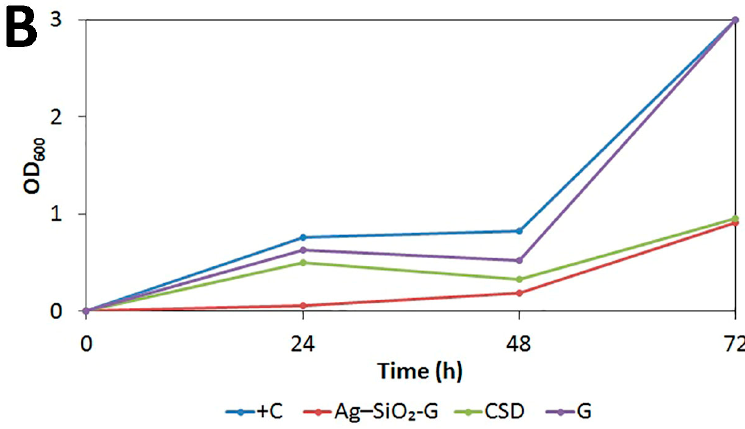
Figure 7. Growth curves of ( A ) MRSA and ( B ) E . coli in MHB in the presence of no inhibitor (+C), Ag–SiO 2 -G, CSD, and pristine gauze (G). Each data point represents the average of five consecutive measurements. The standard errors were too small to be depicted. The data shown is a representative of two independent experiments.